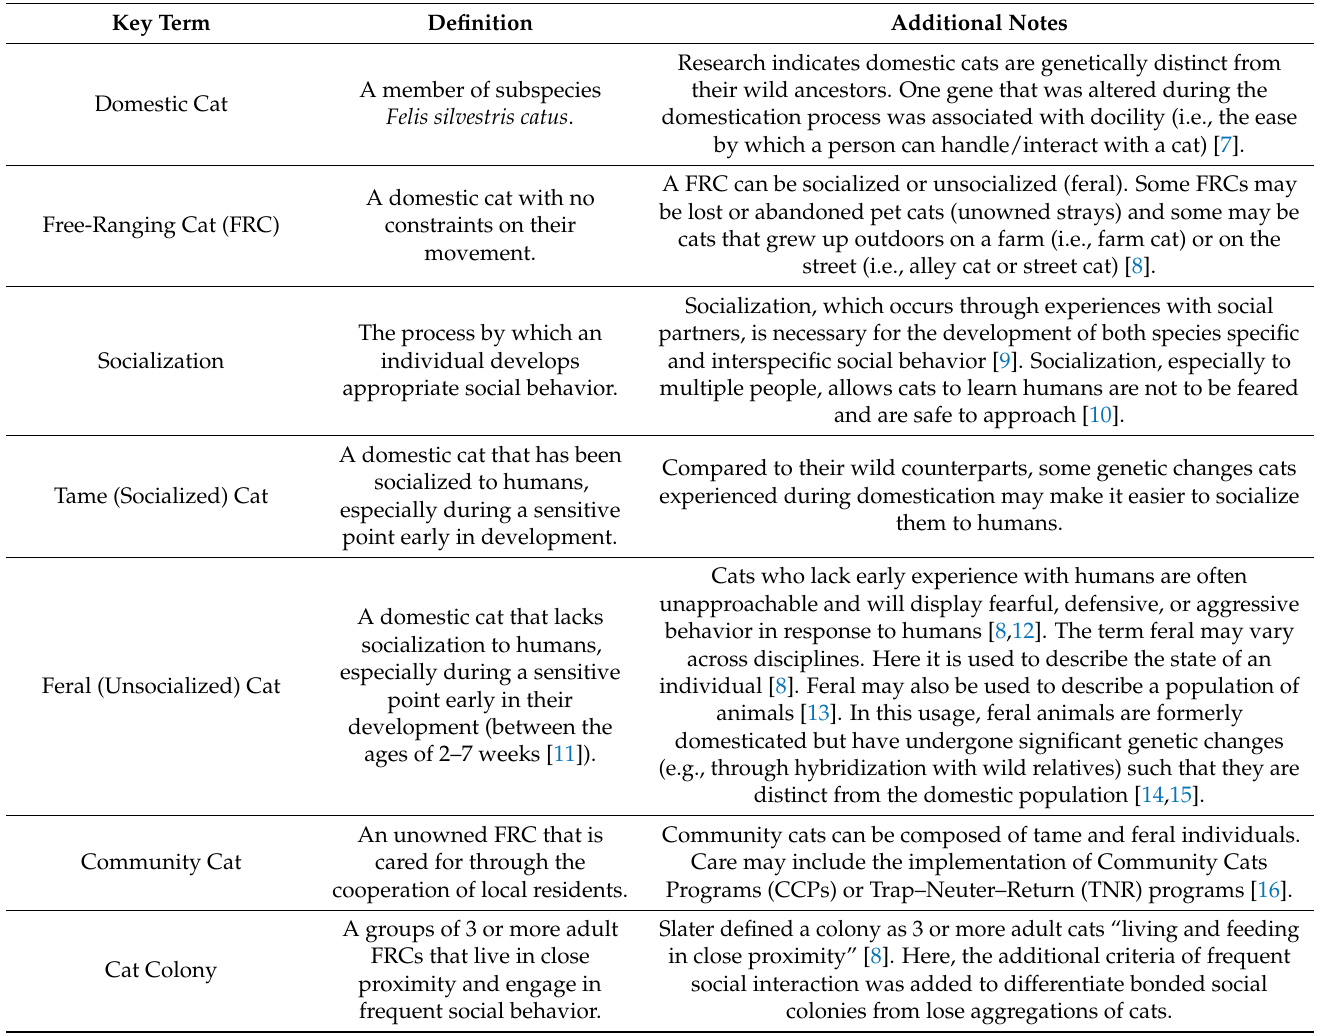
Table 1. Definitions of key terms related to free-ranging cats